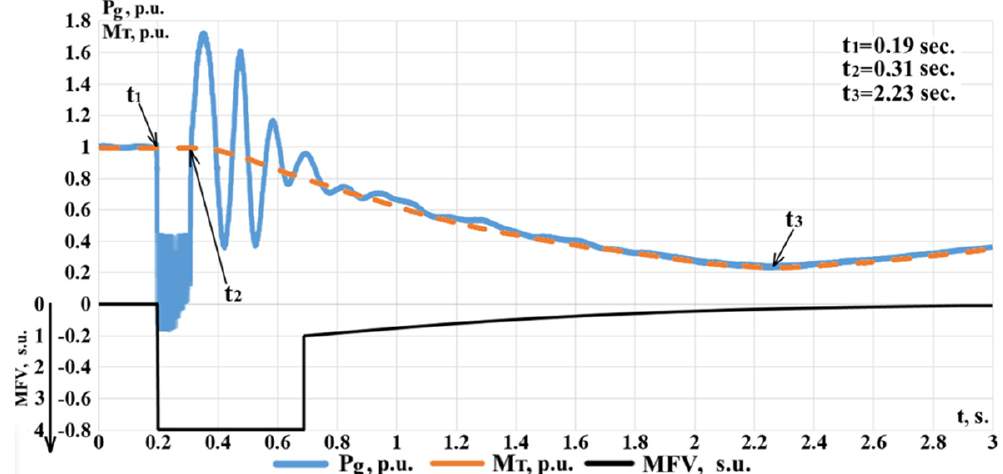
Figure 13. Generator G 2 active power and turbine torque for a case of FV ( A i = 4 pu).